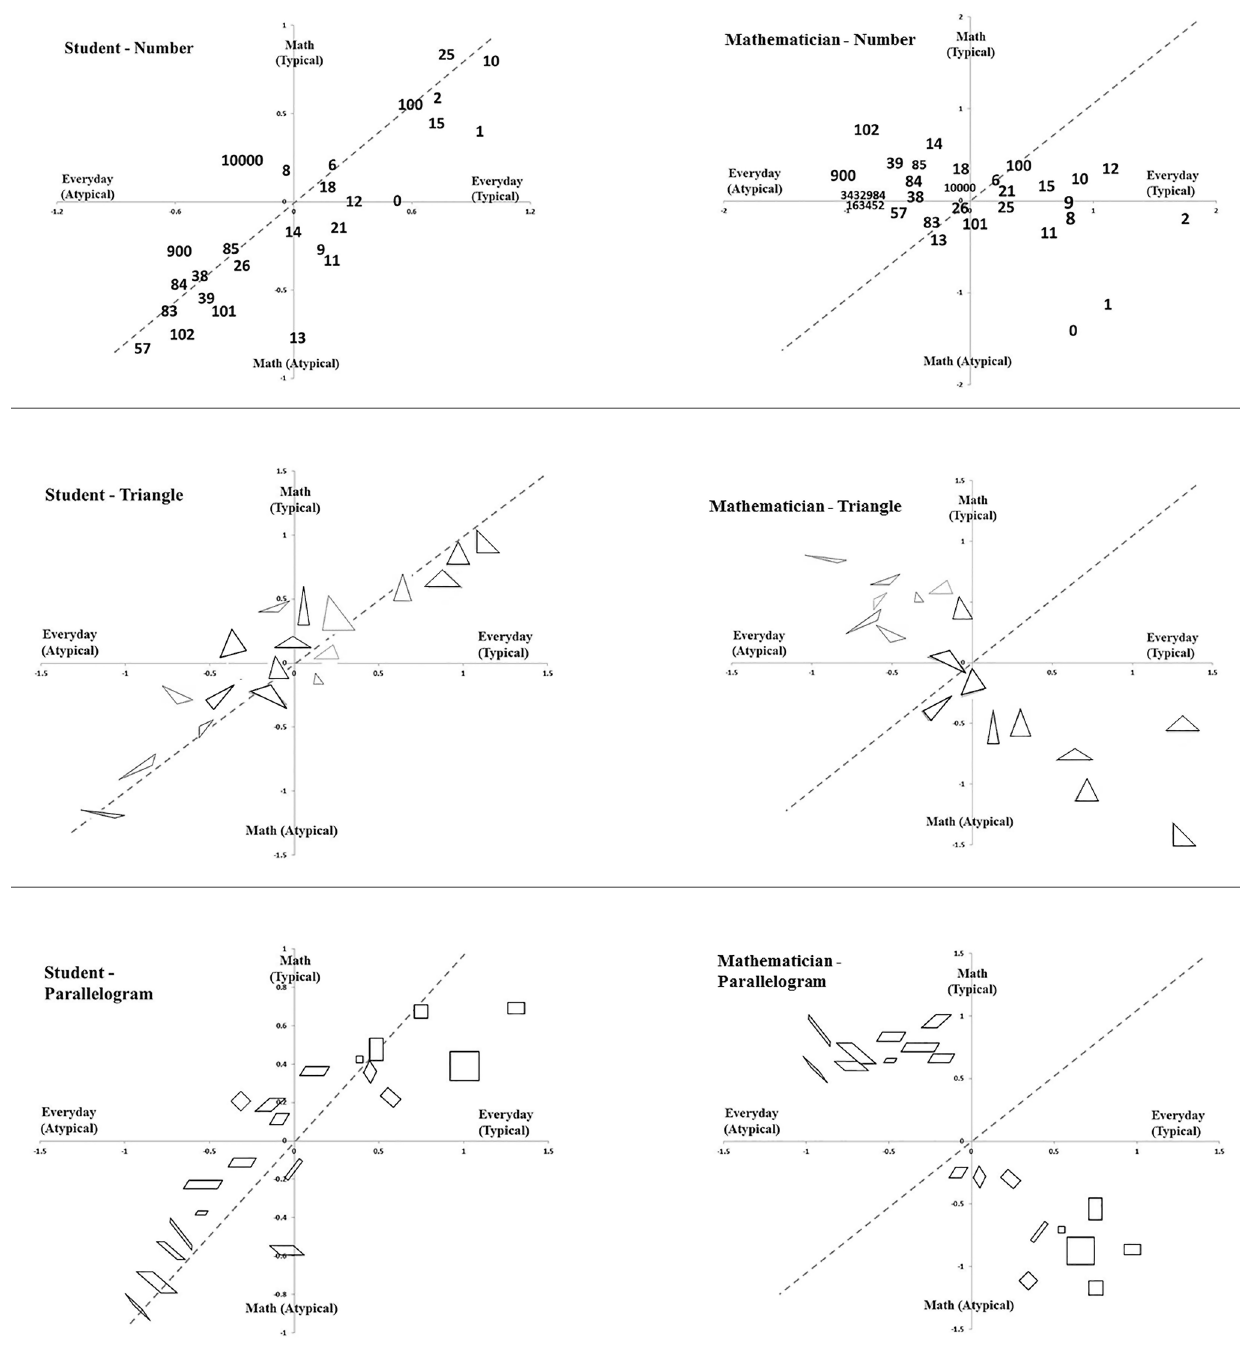
Figure 2. Middle school students’ and mathematicians’ average ratings of numbers (top), triangles (middle), and parallelograms (bottom), in a mathematical (y-axis) and everyday (x-axis) context,